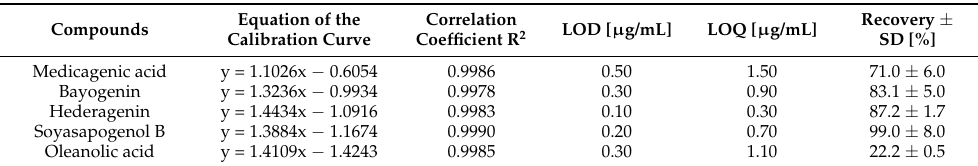
Table 3. Calibration data including: calibration equations, linearity coefficient (R 2 ), LOD, LOQ and recovery ( n = 3).